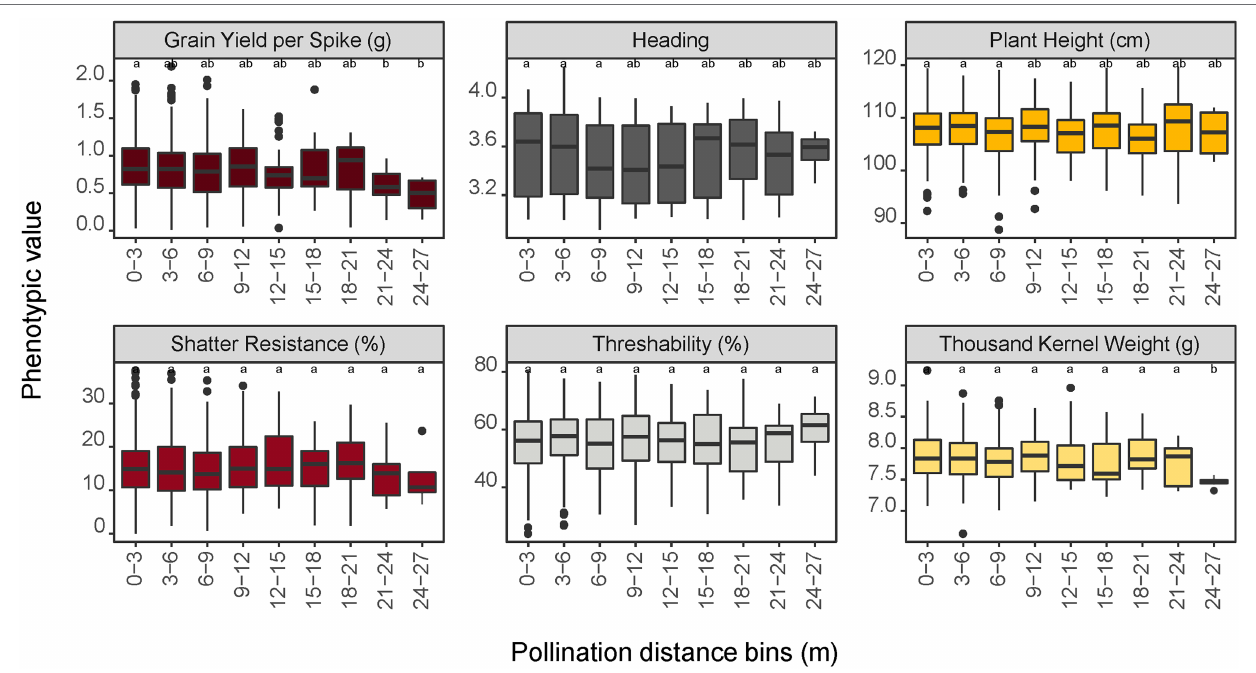
FIGURE 5 | Impact of pollination distance bins on trait performance of the progeny population predicted by a genomic prediction model. Values with different letters are significantly different at α = 0.05 level according to the LSD test among the bins. For shatter resistance, a lower trait value is preferred (i.e., less prone to shatter in the field) whereas a higher value is preferred for threshability (more % of de-hulled grain) and thousand kernel weight (larger